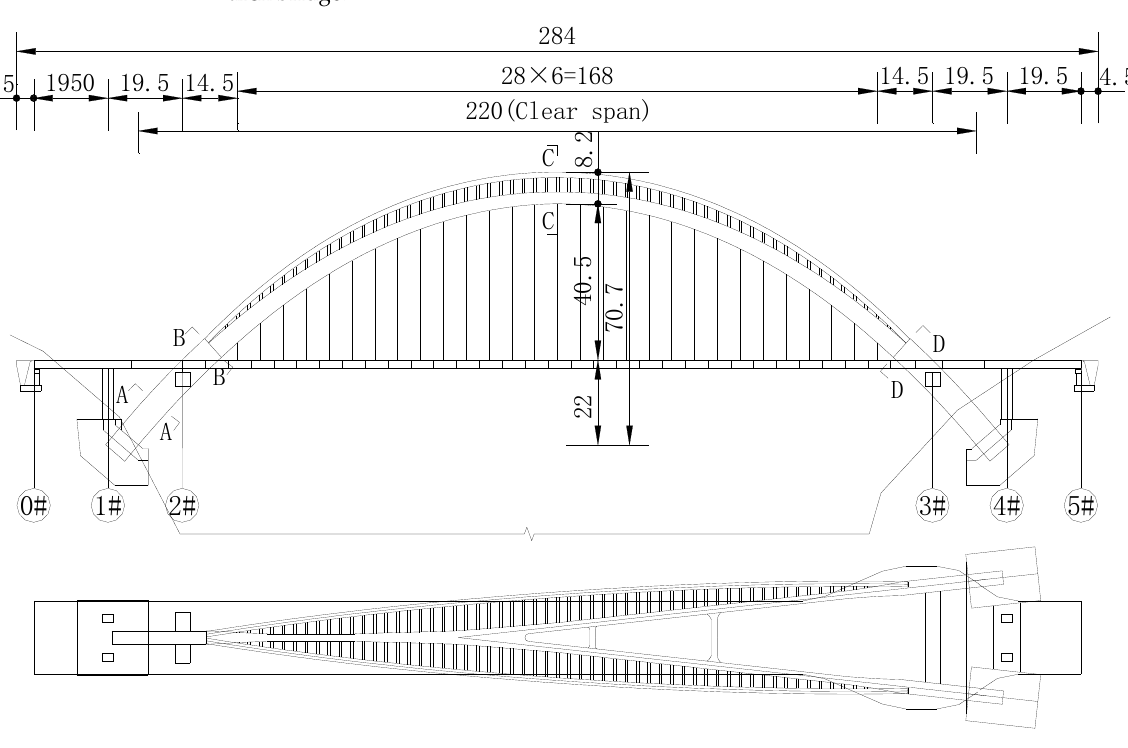
Figure 3. General layout of the main and secondary arch collaborative Y-shaped steel box arch bridge (unit: